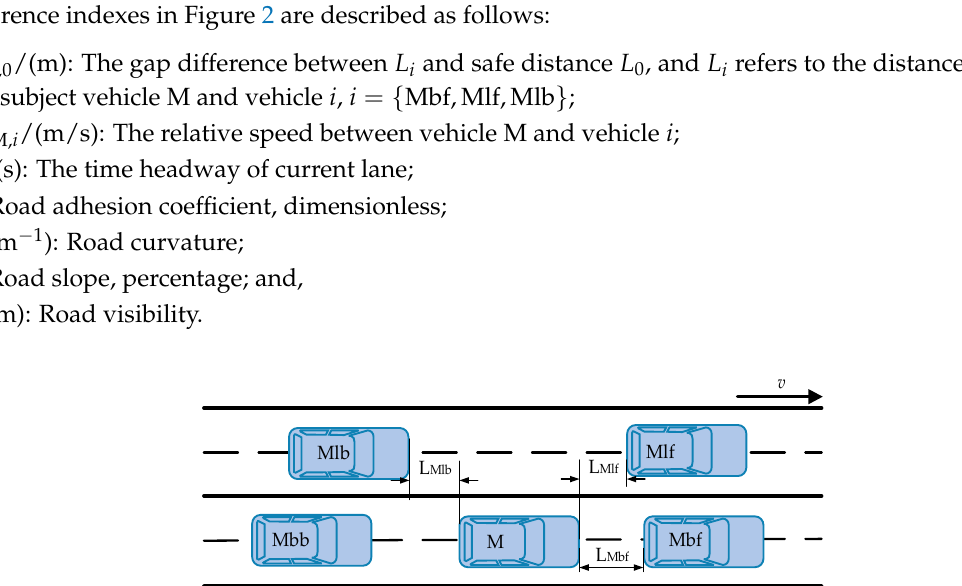
Figure 3. Diagrammatic sketch of vehicle states.